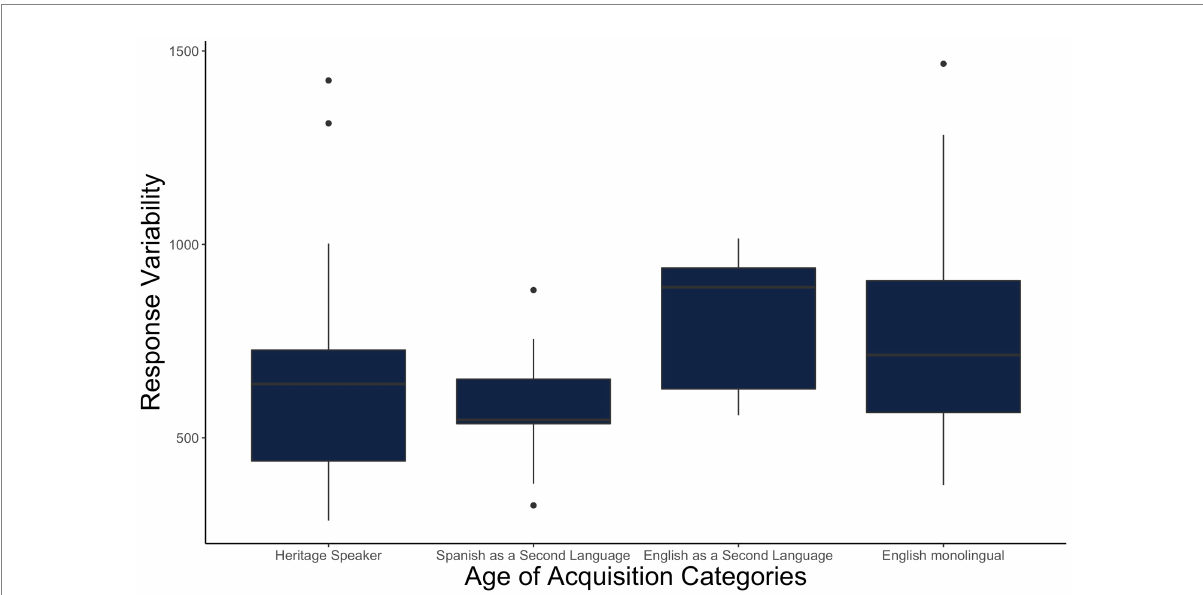
FIGURE 6 The residual variance calculated through the above formula on the y-axis. The higher the variance, the noisier the responses are. Here, we plotted four categories that were extracted from the Age of Acquisition variable from our